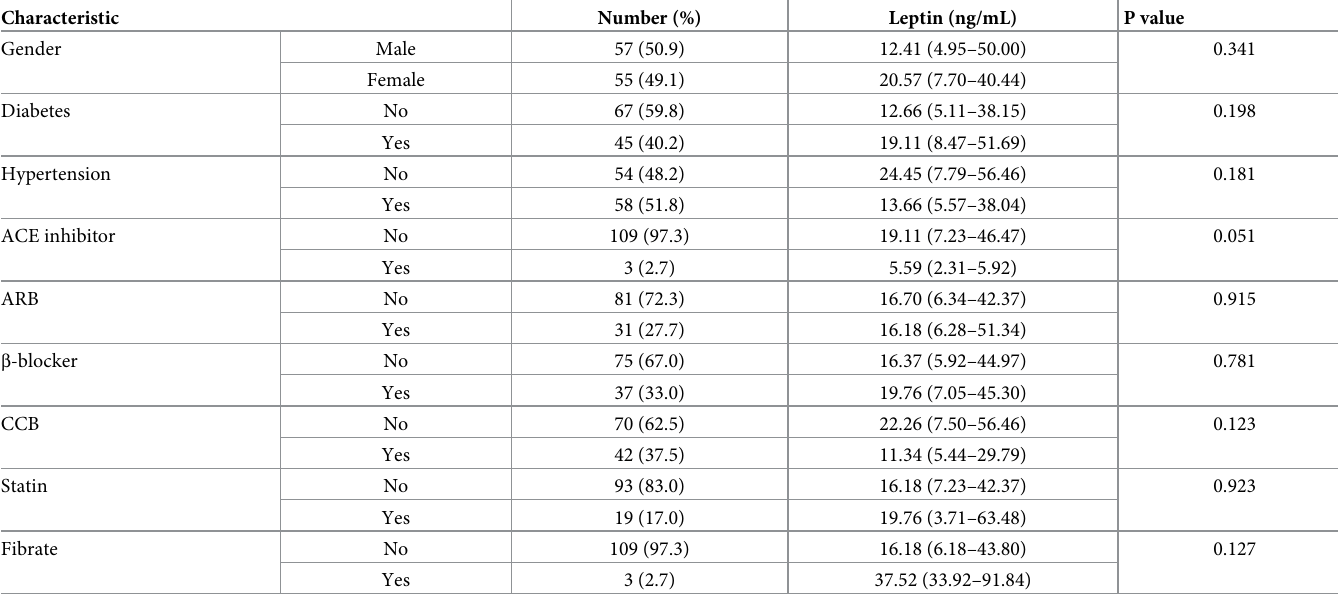
Table 3. Clinical characteristics and serum leptin levels of 112 hemodialysis patients.